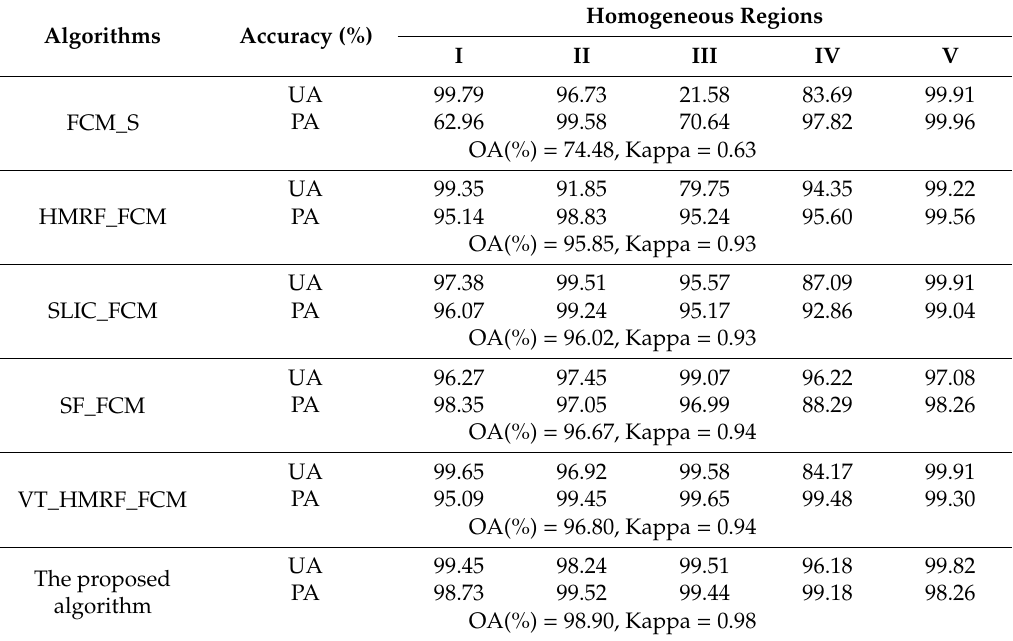
Table 3. Quantitative evaluation of simulated image segmentation results.